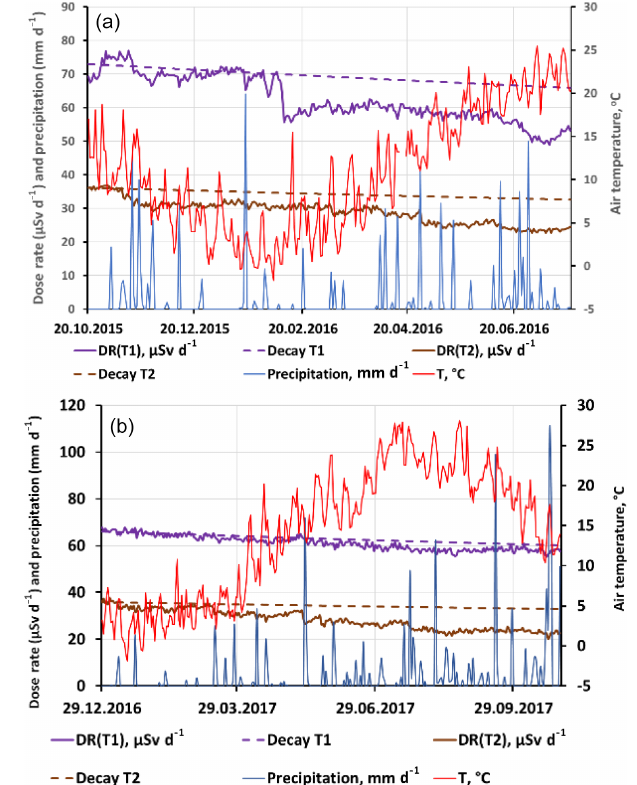
Figure 2. The time dependence of the D-shuttle readings (µSvd − 1 ) recorded with collimated shield from spot on the soil surface 10cm below the dosimeter for the two sites T1 and T2 located in the Takase river catchment for two observation periods: October 2015 to July 2016 (a) and December 2016 to October 2017 (b) and data of daily precipitation (mmd − 1 ) and daily average air temperature ( ◦ C) recorded by Namie meteorological station of Japan Meteoro- logical Agency for the similar time windows.